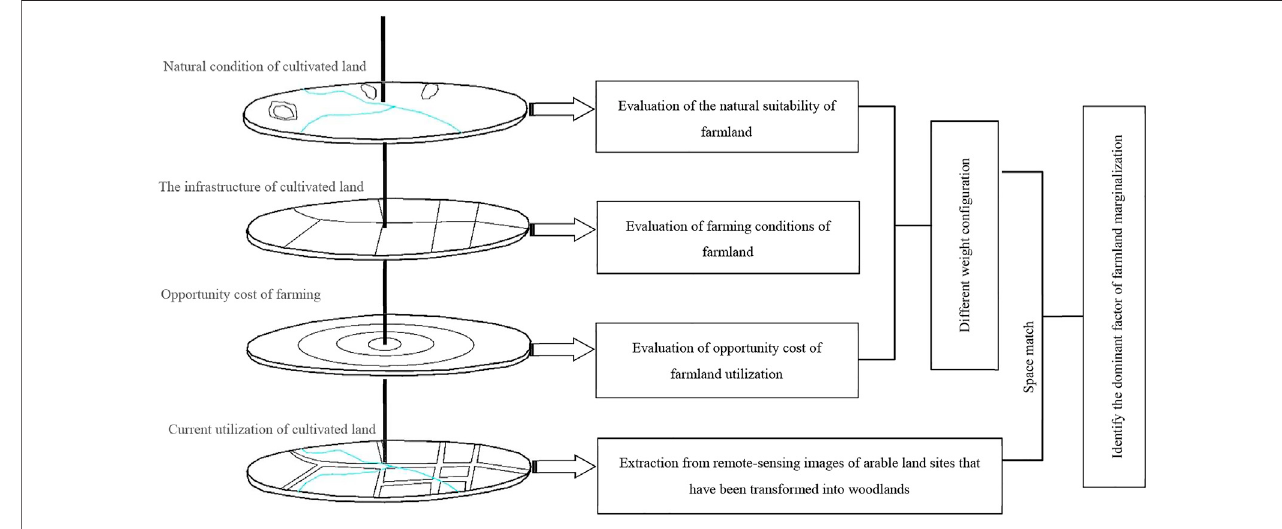
FIGURE 1 | Conceptual framework for the identi fi cation of marginal factors of farmland.